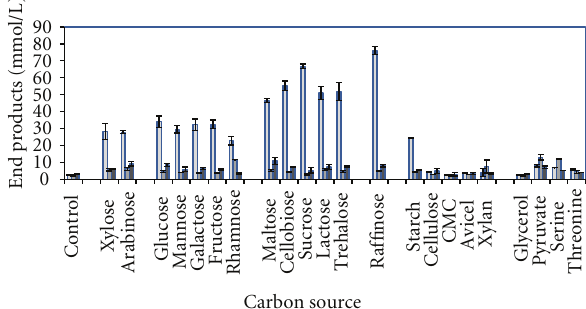
Figure 2: End product formation from various substrates by strain J1. Data represents average of two replicate experiments. Standard deviation are shown as error bars. From left to right; ethanol, acetate and